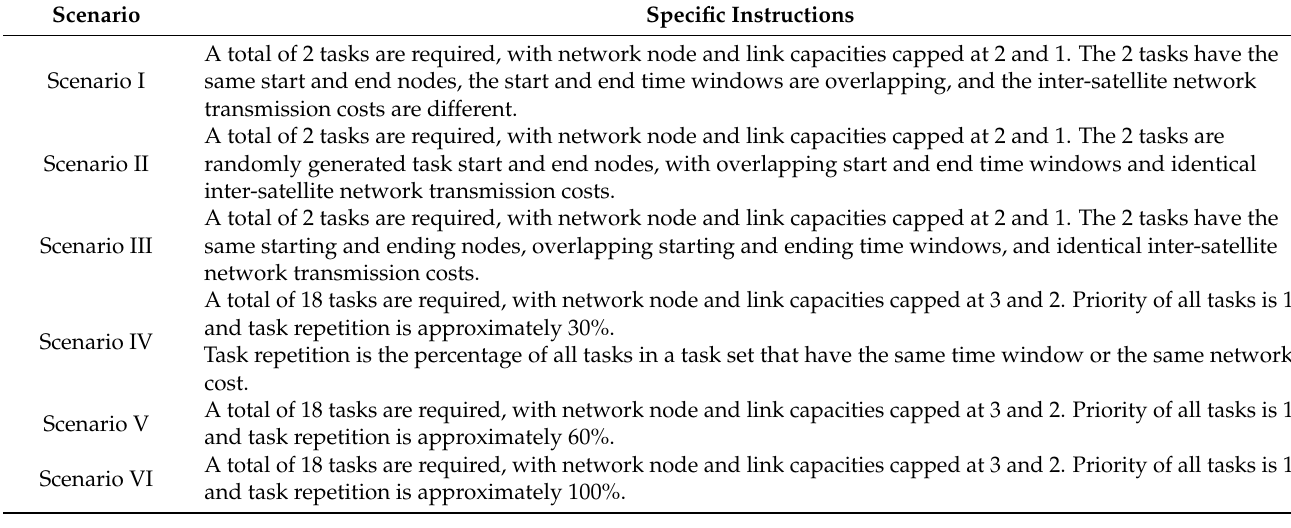
Table 7. Scenario Description.